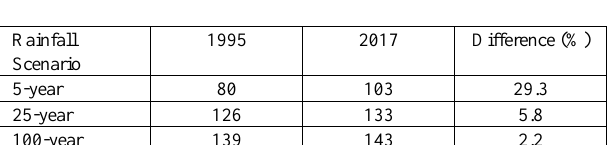
Table 8. Area of simulated flood extents for Butuan City (in km 2 ).